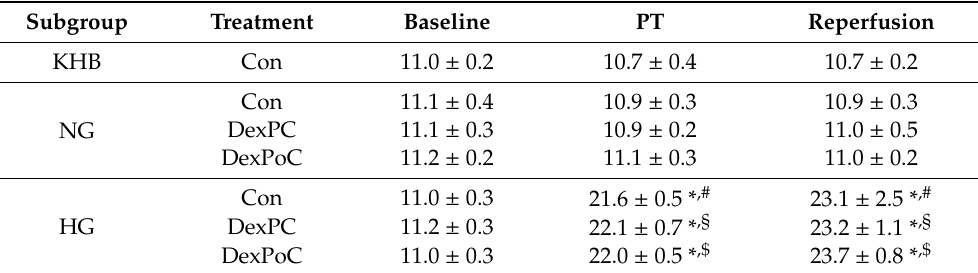
Table 3. Glucose values (mmol /